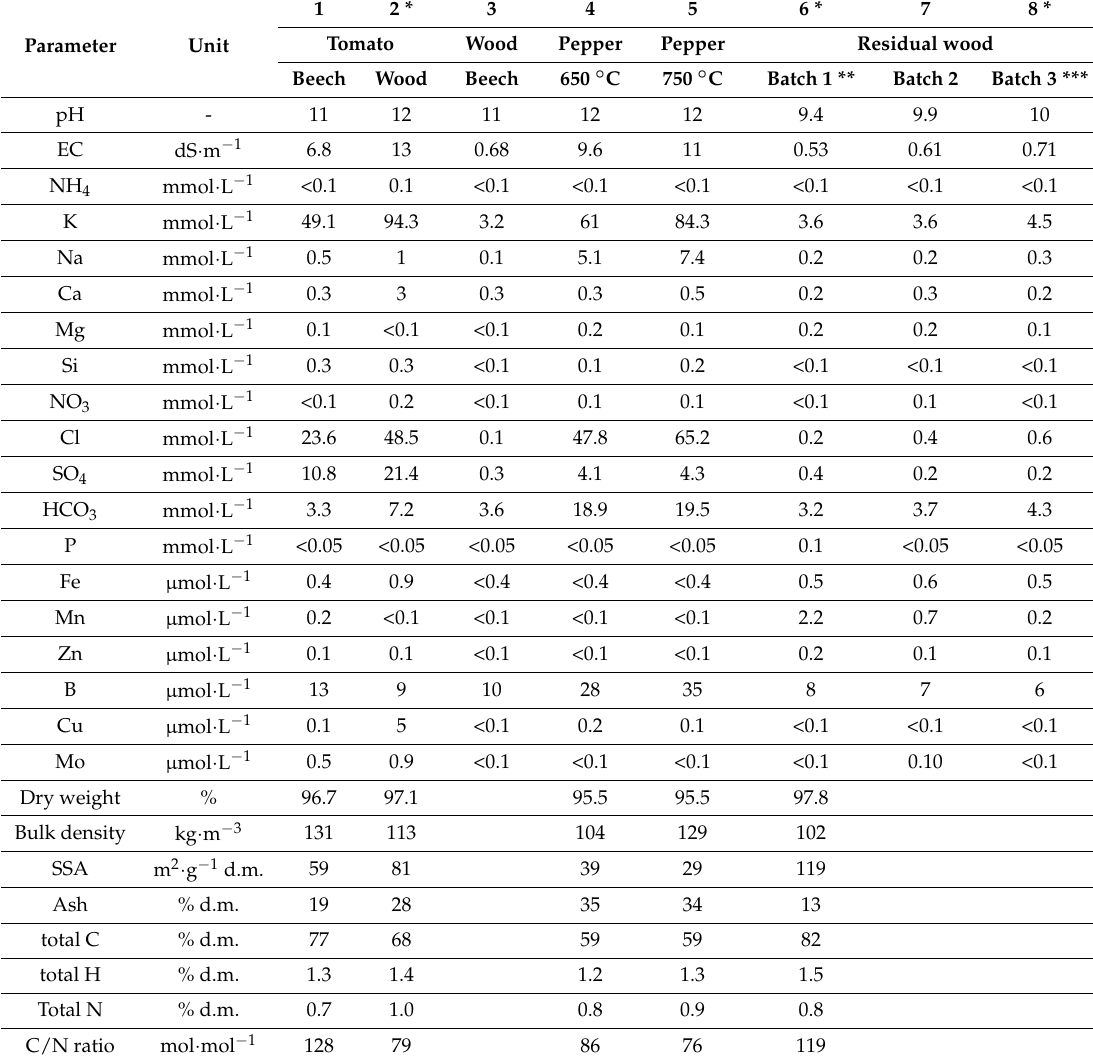
Table 2. Properties of biochars produced from different feedstocks or with different temperatures.